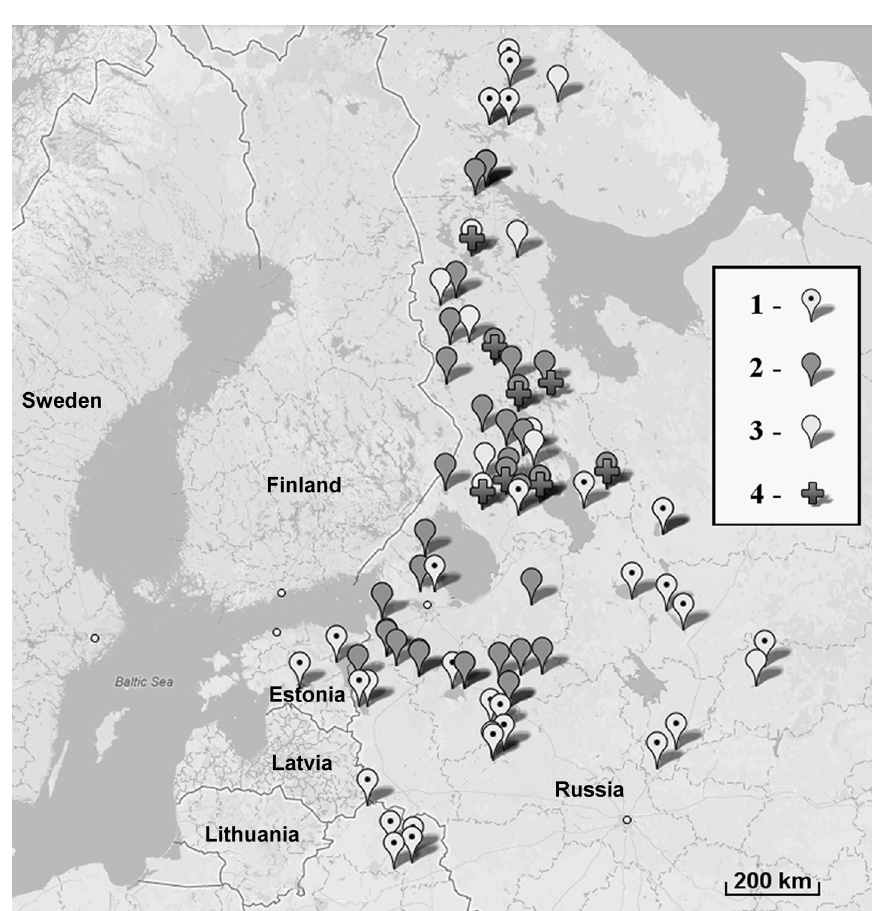
Fig. 1. Map of the study area and investigated lakes with the following observation periods: 1, 1881(cid:150)1953 (Piotrovich 1958); 2, 1936(cid:150)1989 (hydrological yearbooks); 3, closed bays; 4, data for the Republic of Karelia with the observation period up to